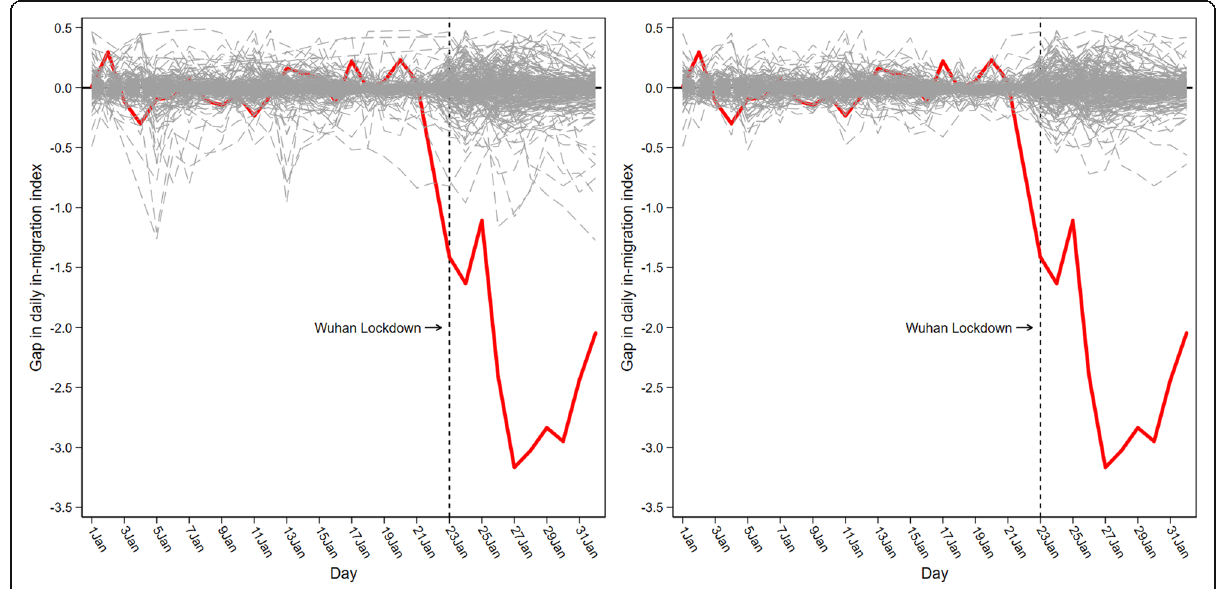
Fig. 4 IMI gaps in Wuhan and placebo gaps in 278 control cities